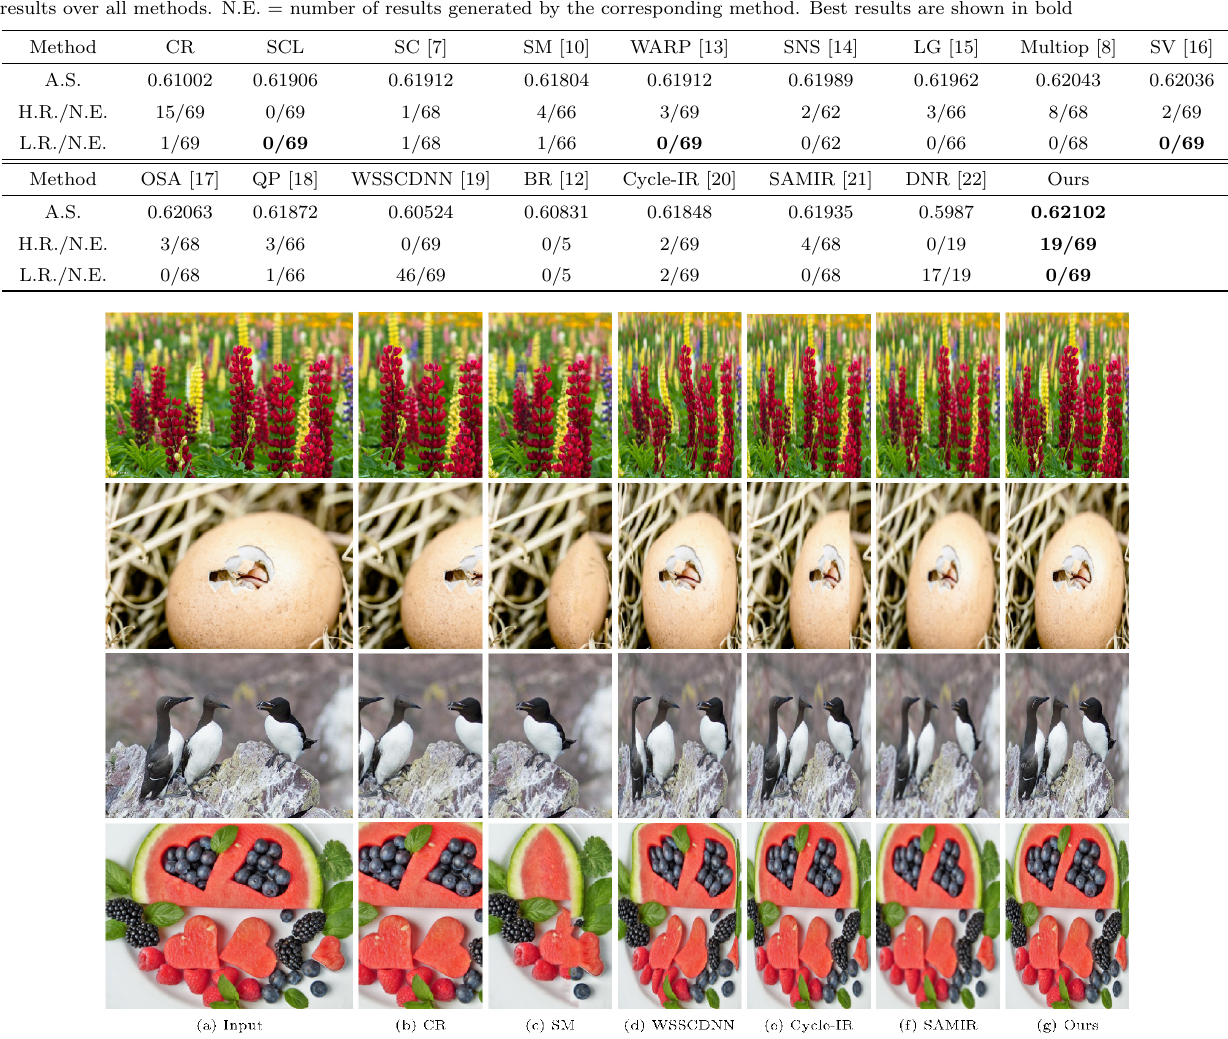
Fig. 11 Results of the proposed method and deep learning-based image resizing to 50% of the original width. The retargetability scores of input images from top to bottom are 0.68, 0.56, 0.54, and 0.23, respectively